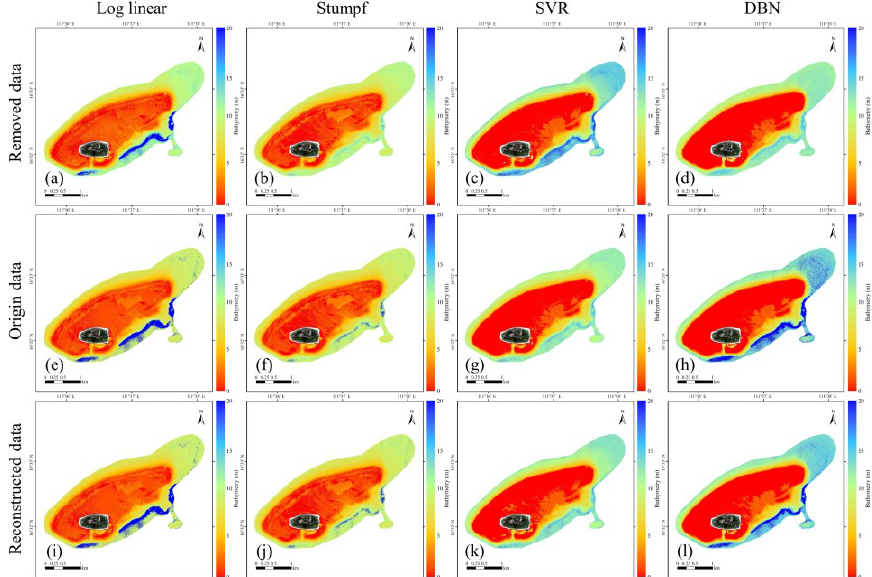
Figure 8. Shallow-water bathymetric maps derived from four models with three groups of data in the Shanhu Island study area. ( a – d ) Bathymetric maps derived from four models based on data with manual removal; ( e – h ) Bathymetric maps derived from four models based on origin data; ( i – l ) Bathymetric maps derived from four models based on reconstructed data.